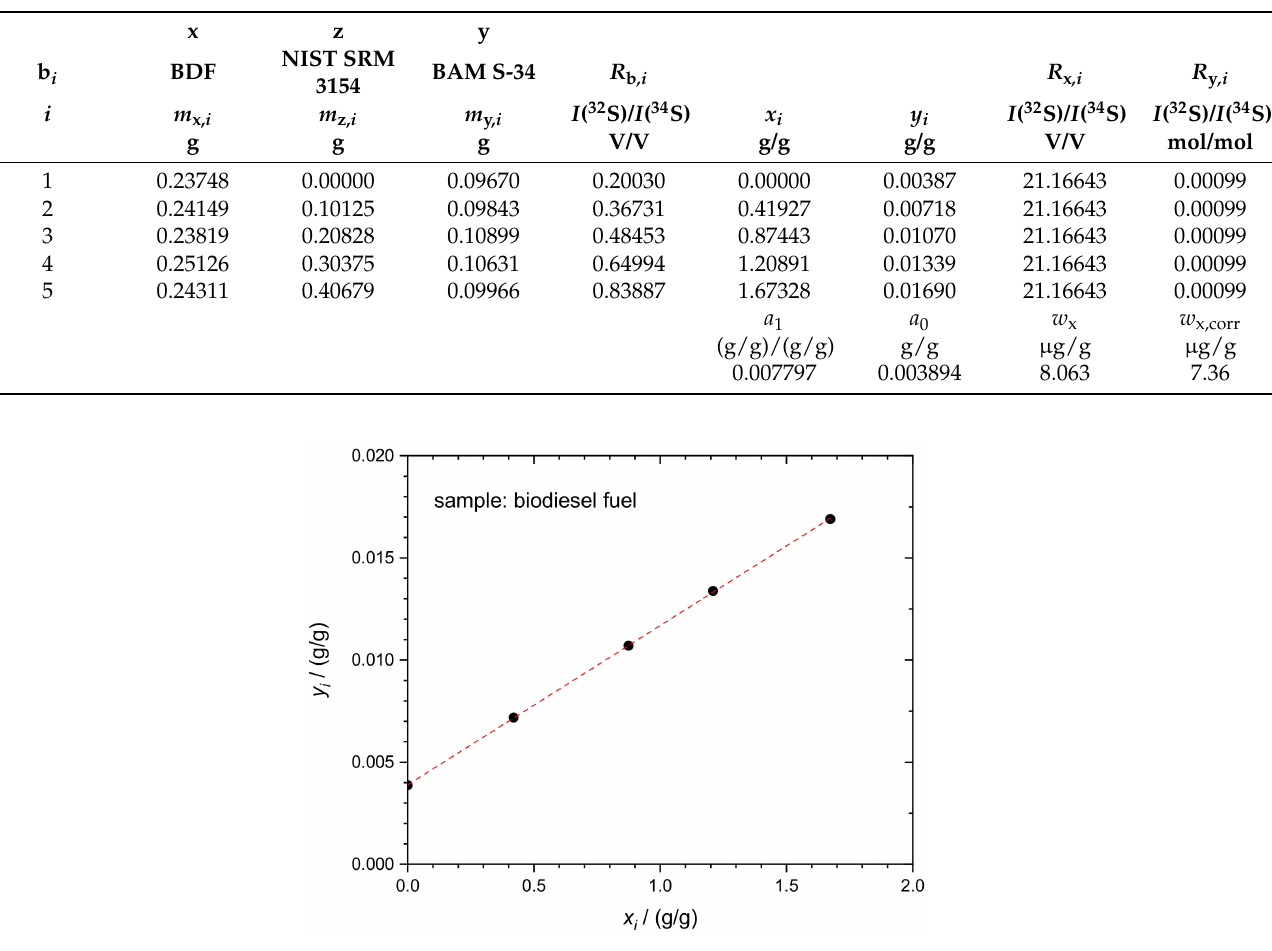
Figure 5. Linear regression of the S mass fraction in biodiesel fuel according to Equation (2). Dataset in Table